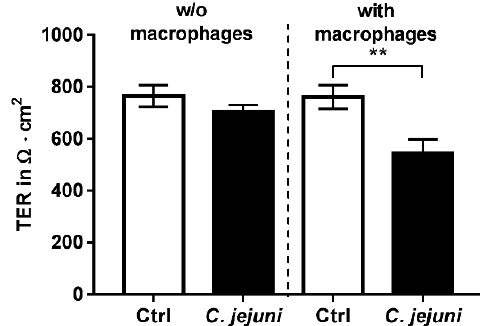
Figure 1. C. jejuni infection in human intestinal epithelial cells (HT-29 / B6-GR / MR) or in co-culture together with human immune cells (differentiated THP-1 cells). Transepithelial electrical resistance (TER) in co-culture after C. jejuni infection from the basal side decreased 48 h post infection ( n = 7–9, ** p < 0.01, unpaired Student’s t -test).